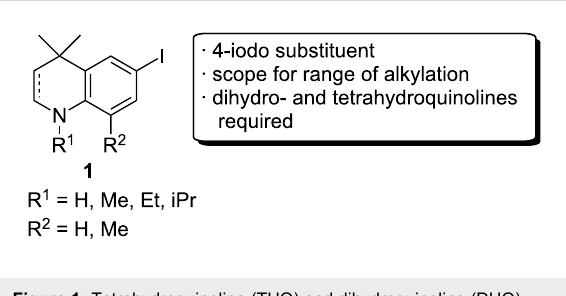
para -position relative to nitrogen (the 6-position) was required for further functionalisation by typical cross-coupling